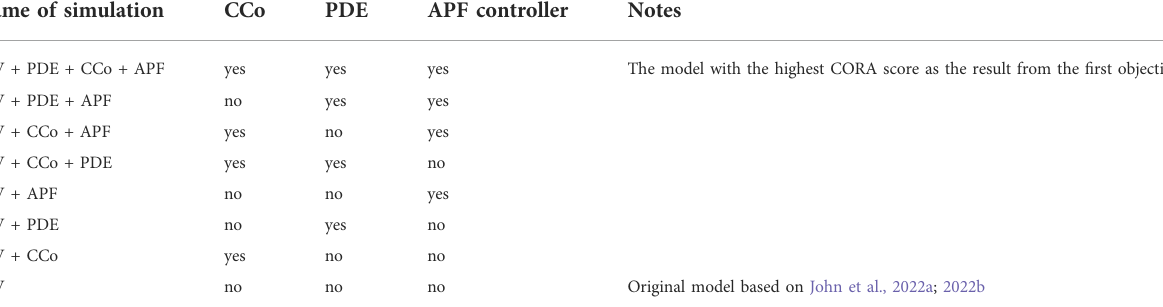
TABLE 2 Parametric simulations of model con fi guration.